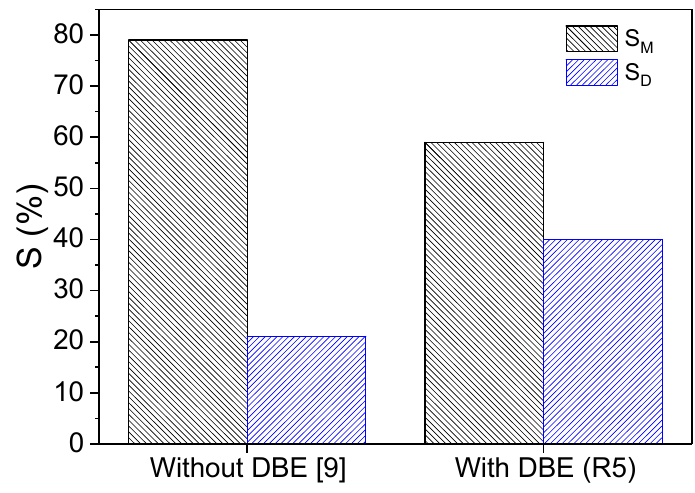
Figure 2. E ff ect of DBE on the selectivity towards the reaction products (M and D). Figure 2. Effect of DBE on the selectivity towards the reaction products (M and D).